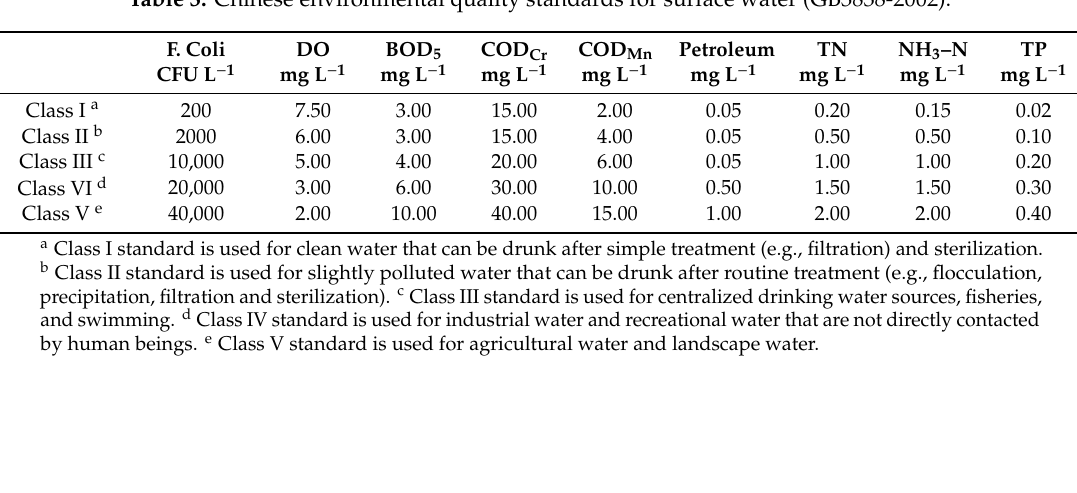
Table 3. Chinese environmental quality standards for surface water